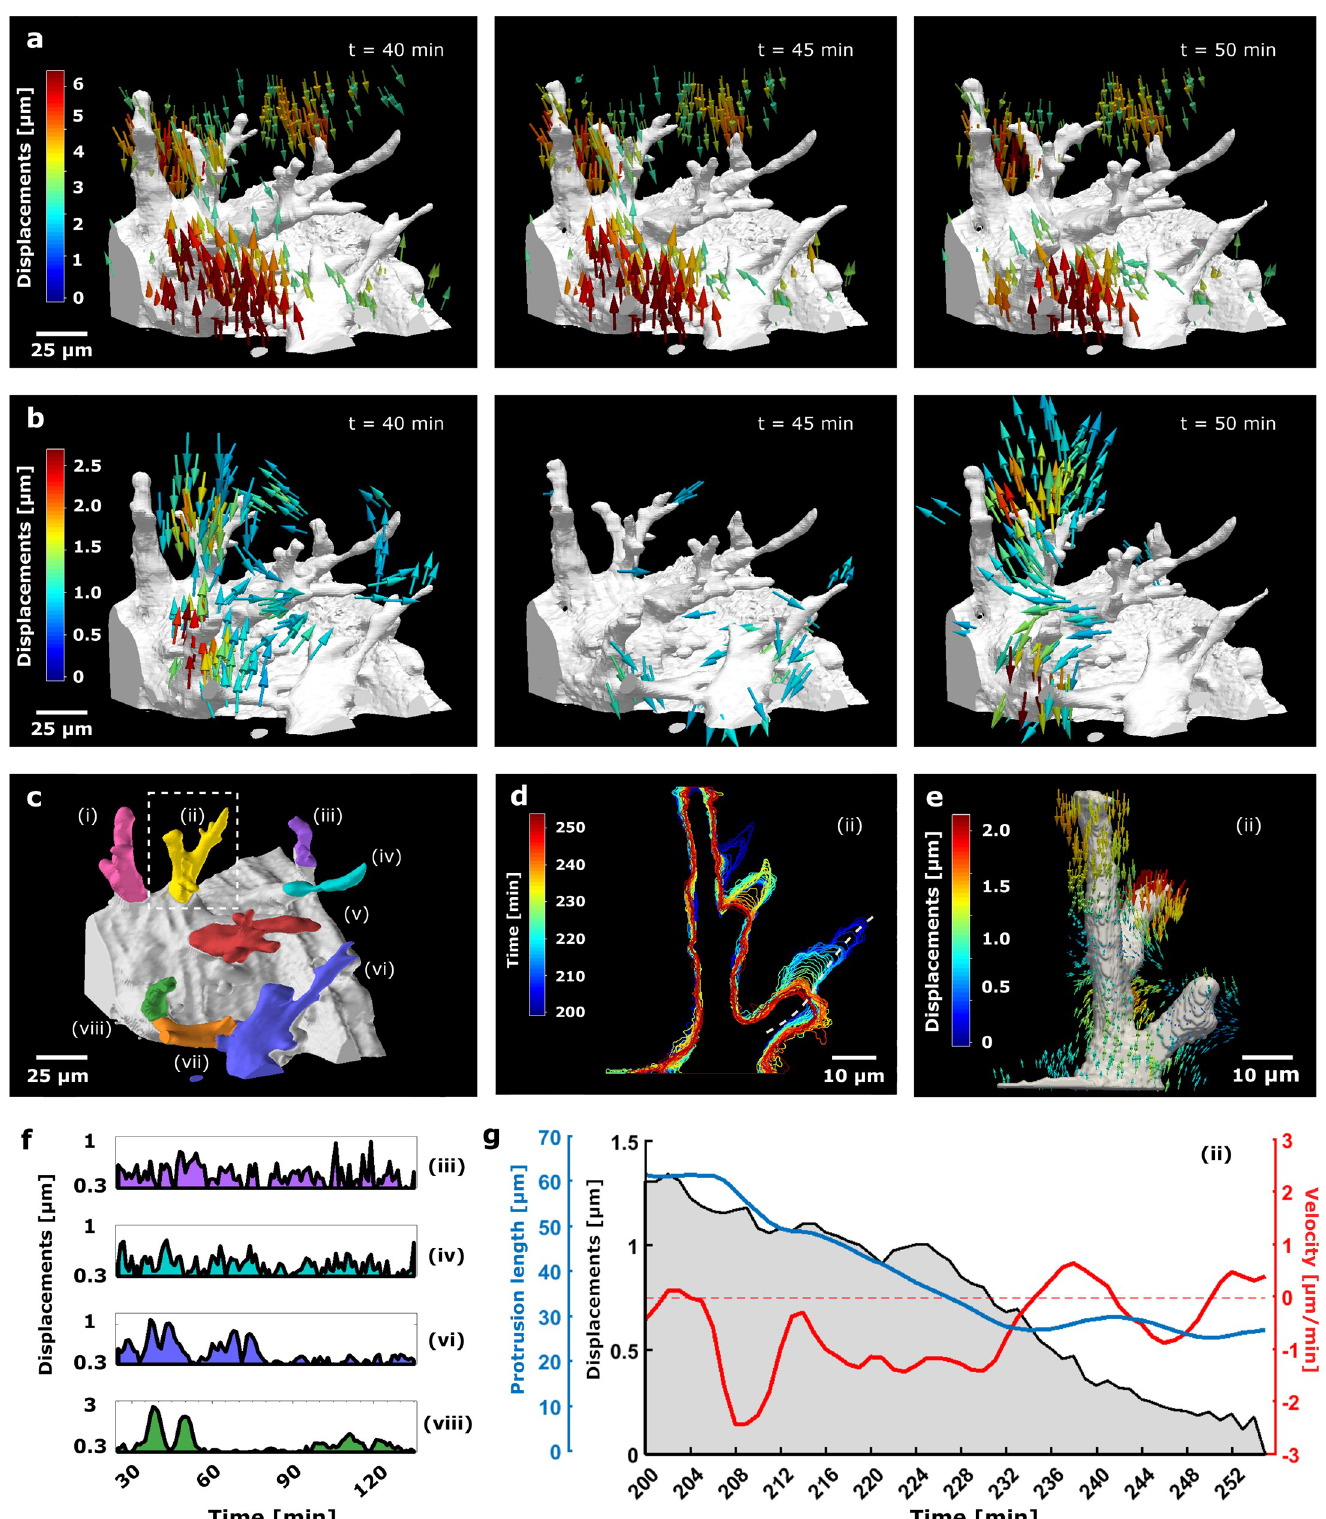
Fig 2. 4D SPIM-based displacement microscopy enables matrix displacement quantification at high temporal resolution, simultaneously around multiple sprouts and in relation to protrusion dynamics. (a) Absolute (t ref = t fix at t = 255 min) and (b) incremental (t ref = t i − τ ,with τ = 5 min) displacements of indicated